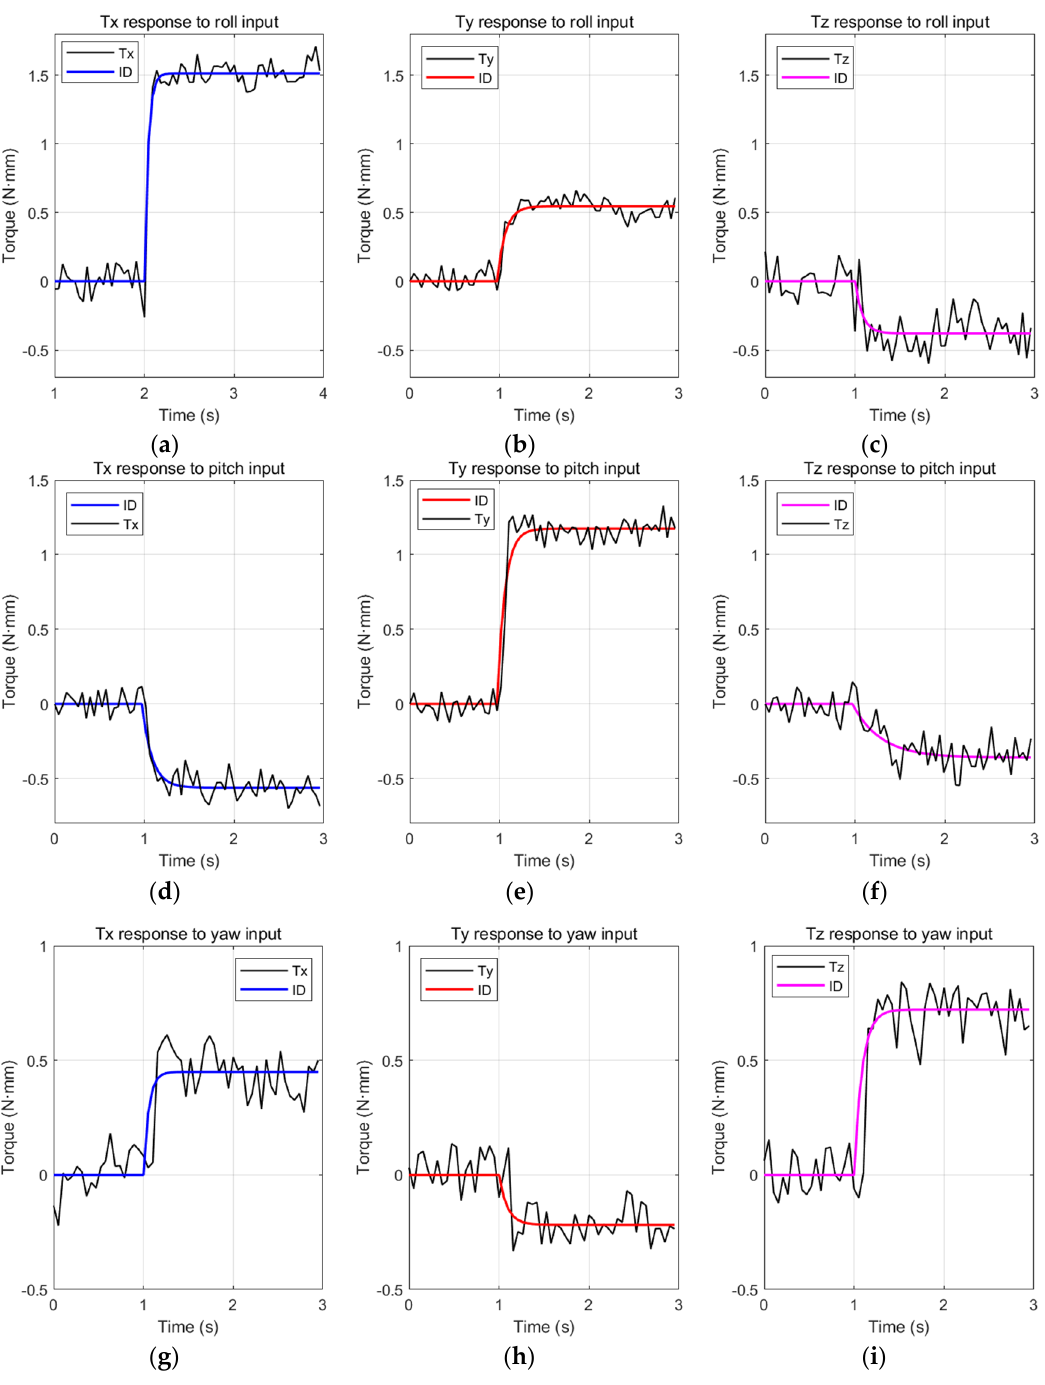
Figure 11. Step responses: ( a ) torque x response to +10% roll input; ( b ) torque y response to +10% roll input; ( c ) torque z response to +10% roll input; ( d ) torque x response to +20% pitch input; ( e ) torque y response to +20% pitch input; ( f ) torque z response to +20% pitch input; ( g ) torque x response to +8 Hz split cycle yaw input; ( h ) torque y response to +8 Hz split cycle yaw input; ( i ) torque z response to +8 Hz split cycle yaw input.